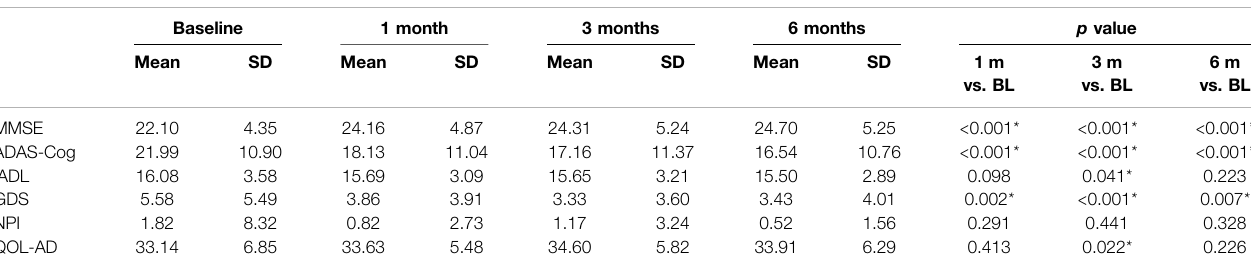
TABLE 5 | Intragroup comparison of clinical scales in the combined group.